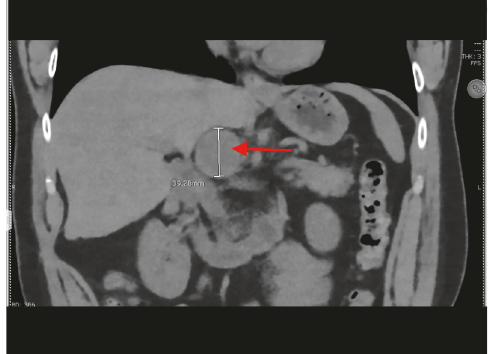
Figure 1: MRI abdomen shows 11 x 12 x 14 cm mixed cystic and solid mass centered in the right adrenal gland.